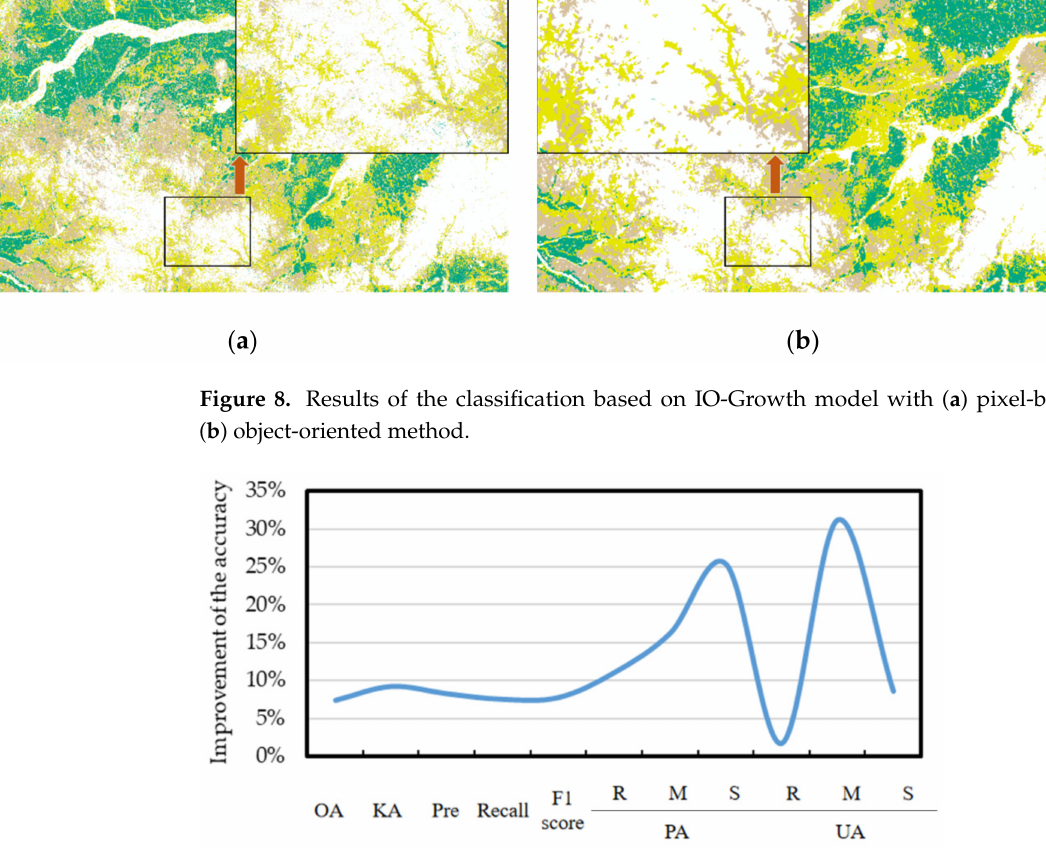
Figure 9. Improvement in the accuracy under the method proposed in this paper calculated in Table